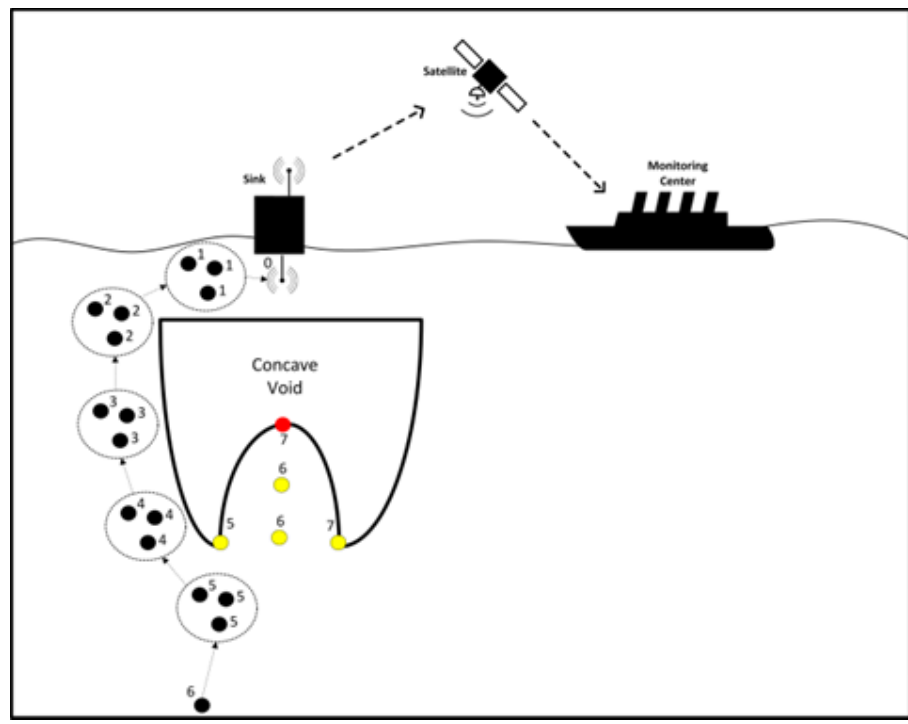
Figure 8. Void-handling technique [46].